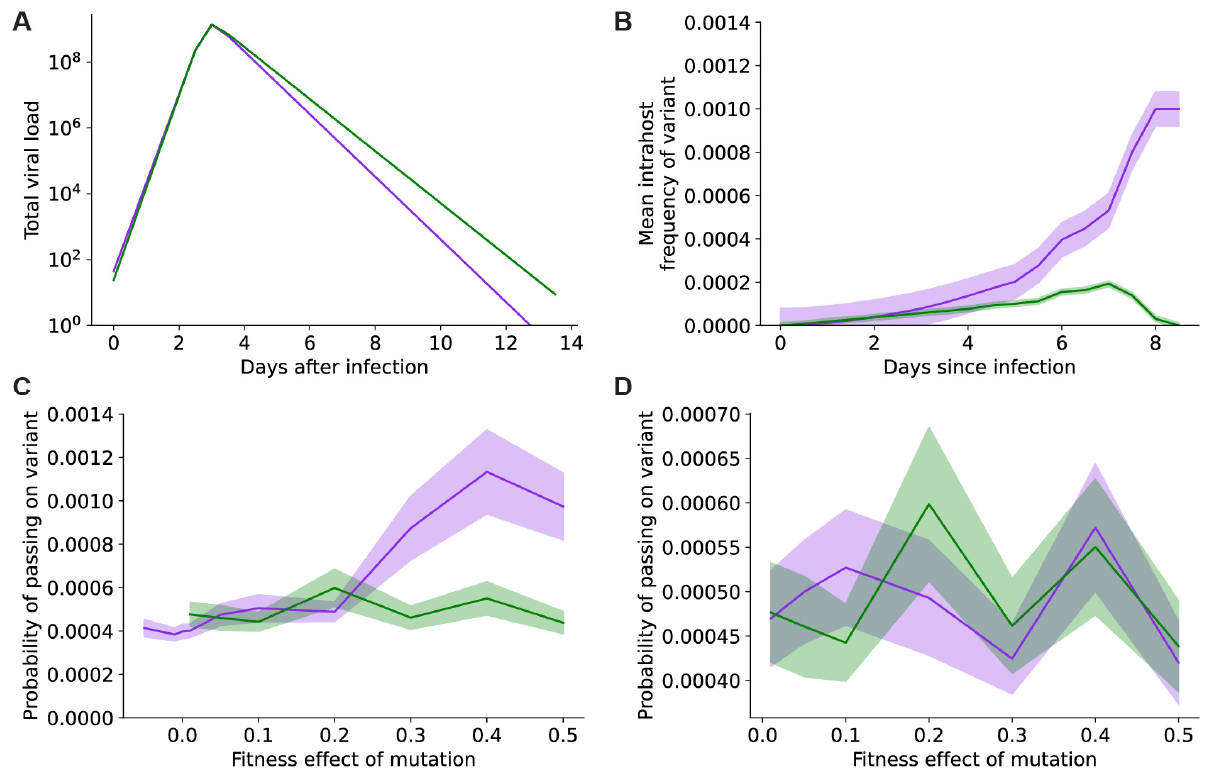
Figure 5. Vaccination does not decrease the rate of generation of new variants within hosts during typical length infections. ( A ) Viral load profiles for vaccinated (purple) and unvaccinated (green) individuals infected with the Delta SARS-CoV-2 variant. ( B ) Frequencies of an advantageous viral variant with a new single mutation (20% fitness benefit over the wild-type) within a vaccinated (purple) or unvaccinated (green) infected individual over a typical-length SARS-CoV-2 infection. ( C ) Probability of generating and transmitting an advantageous viral variant with a new single mutation with a 20% fitness benefit over the wild-type from a host that was vaccinated (purple) or unvaccinated (green). ( D ) Probabilities of generating and transmitting an advantageous viral variant with two new mutations with a 50% fitness benefit over the wild-type from a host that was vaccinated (purple) or unvaccinated (green). In ( B – D ), shaded regions represent 95% binomial confidence intervals.